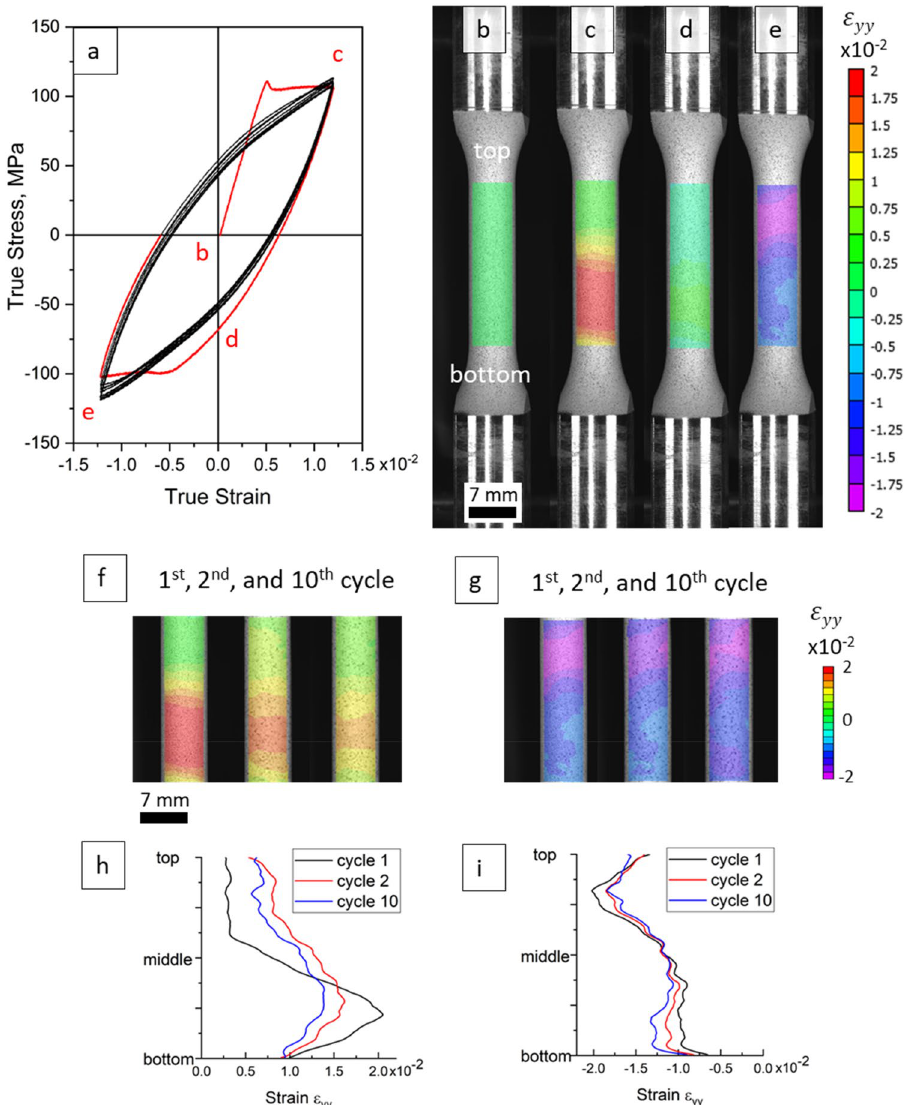
Figure 5. ( a ) Stress–strain curve recorded during cyclic tension–compression loading of the as-extruded alloy. DIC strain fields ε yy during the 1 st loading cycle: initial ( b ), at maximum tension ( c ), unloaded to 0 strain ( d ), and at maximum compression ( e ). DIC strain fields ε yy at maximum tension ( f ) and at maximum compression ( g ) during the 1st, 2nd, and 10th cycles. Distributions of ε yy strain along the gauge section of the specimen after the 1st, 2nd, and 10th cycles at ( h ) maximum tension and ( i ) at maximum